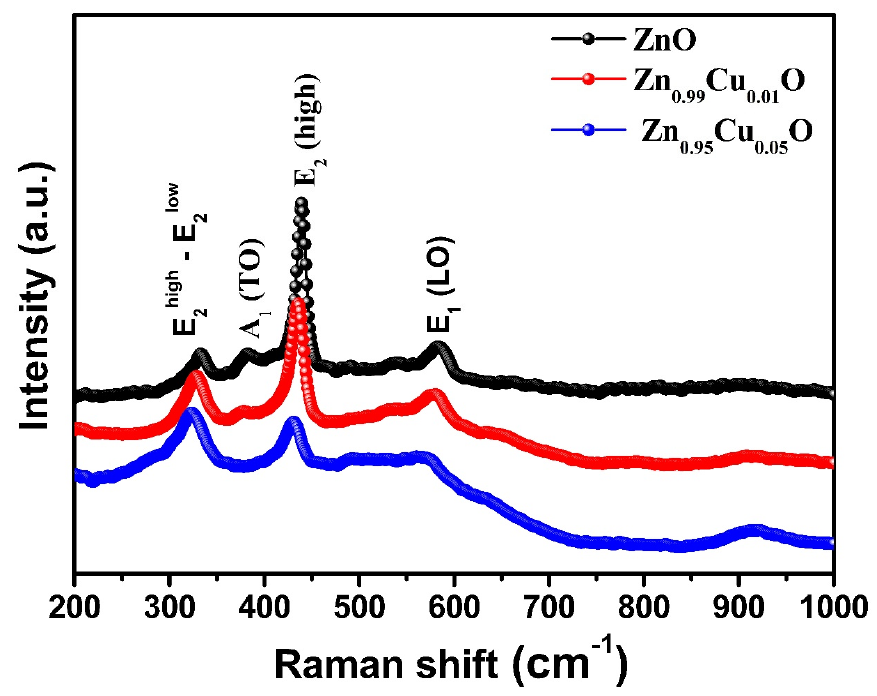
Figure 6. Raman spectra of un-doped and Cu-doped ZnO nanostructures.